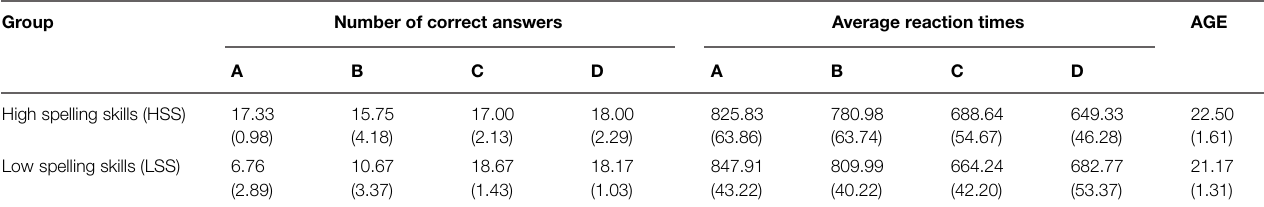
TABLE 1 | Descriptive statistical results, mean and standard deviation (SD) for the number of correct answers and the reaction time for each experimental condition. Group